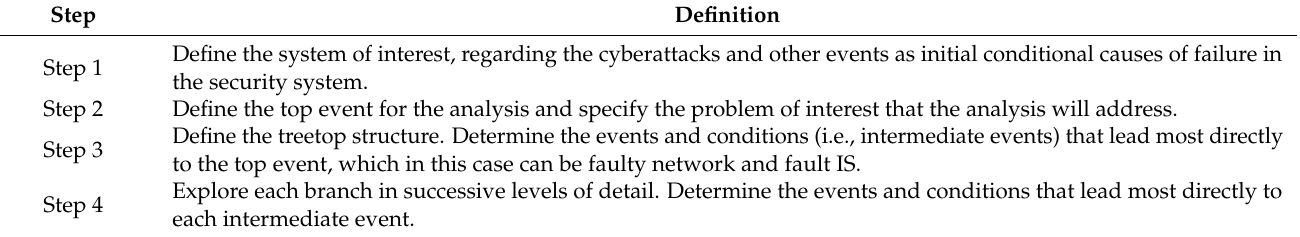
Table 6. Procedure for FTA [75].